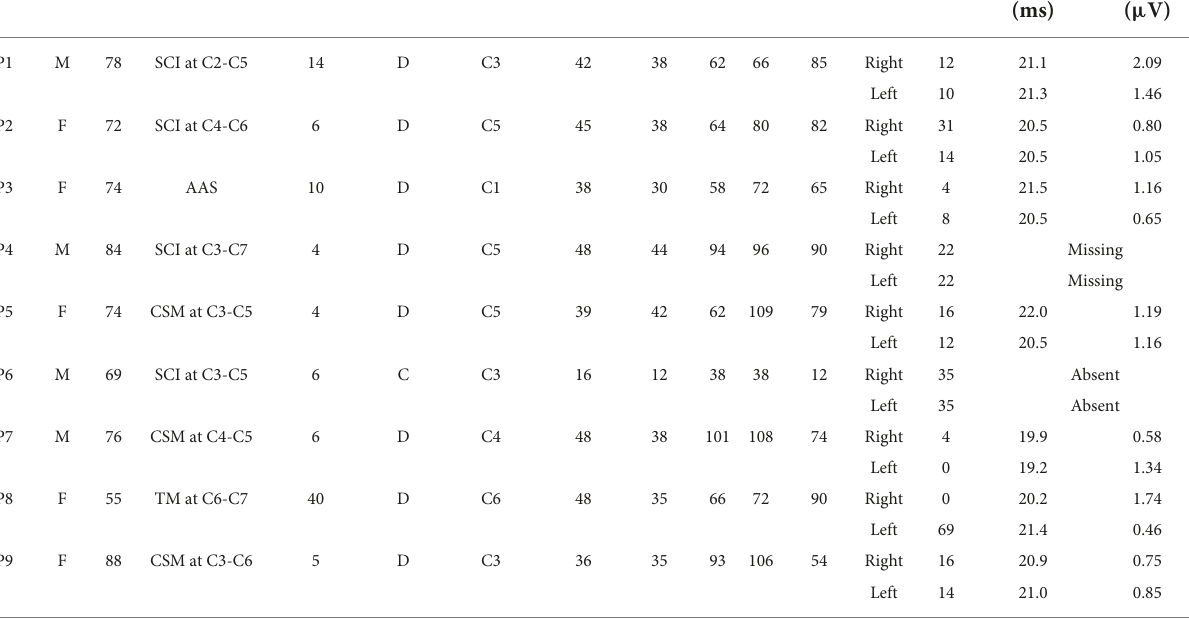
TABLE 1 Clinical features of the nine